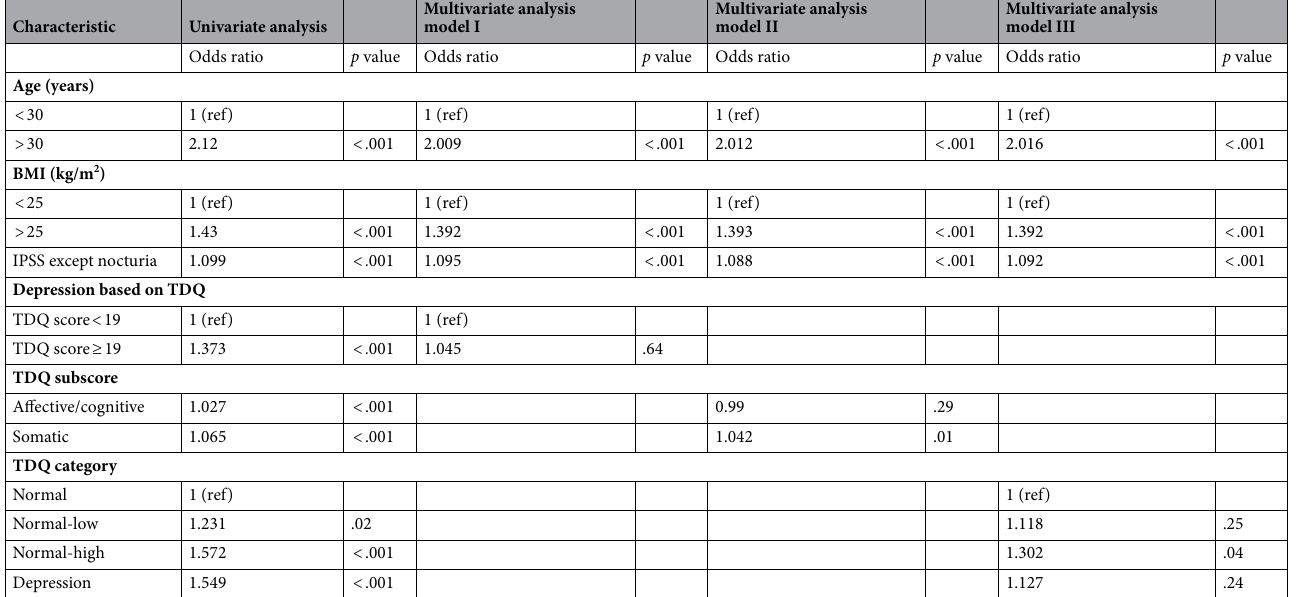
Table 2. Results of the univariate analysis and three multivariate analyses. BMI = body mass index; TDQ = Taiwanese Depression Questionnaire; IPSS = International Prostate Symptoms Score.